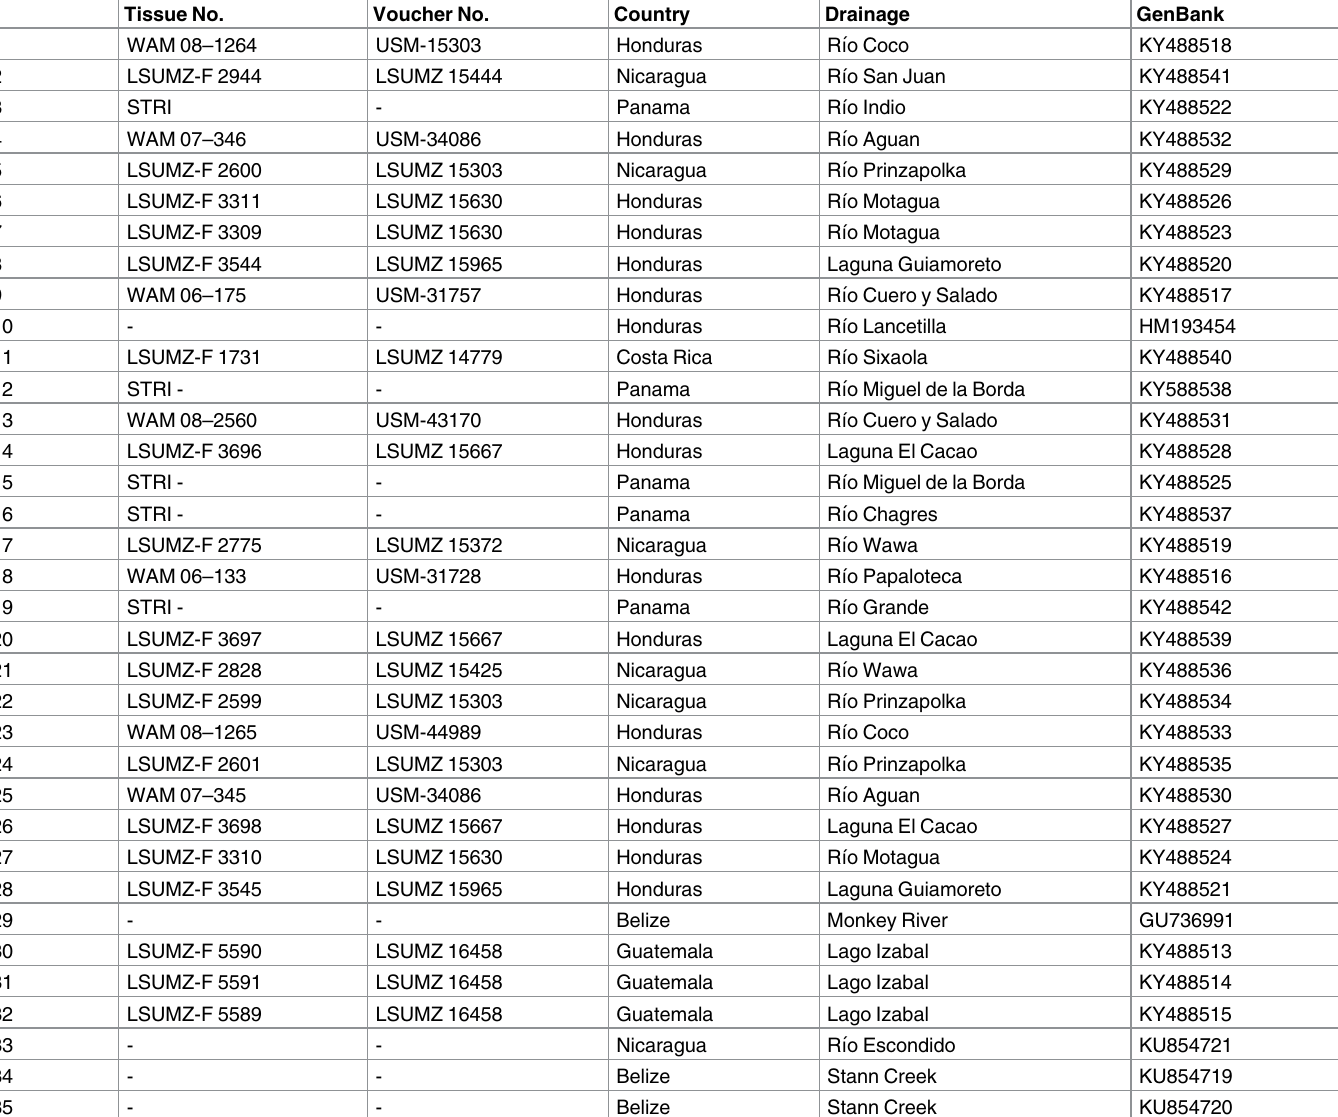
Table 1. Tissue samplesof V . maculicauda used for molecularphylogenetic analyses. Museumacronymsare as follows: LSUMZ, Louisiana State Uni- versity Museum of Natural Science; WAM, W.A. Matamoros; USM, Universityof SouthernMississippi; STRI; Smithsonian Tropical Research Institute. Tissue